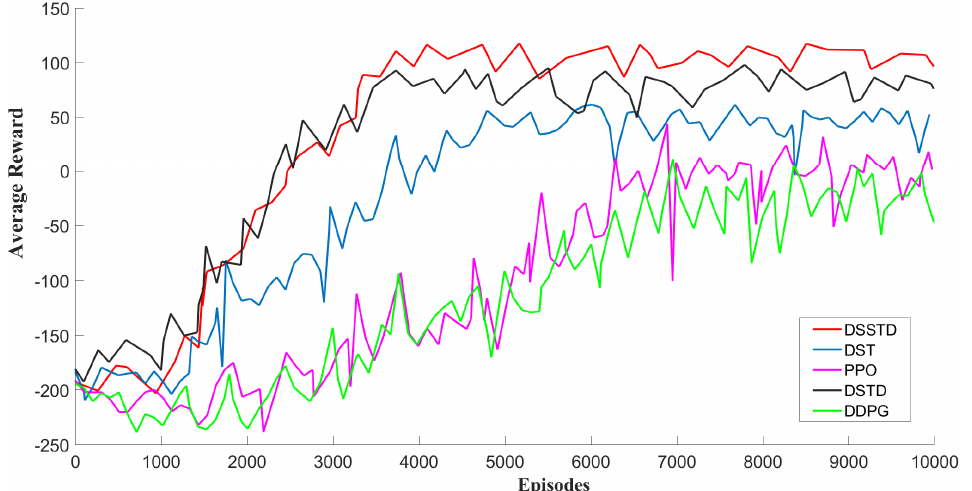
Figure 11. The average reward curve of the proposed RL algorithm and the traditional RL algorithm. 1)